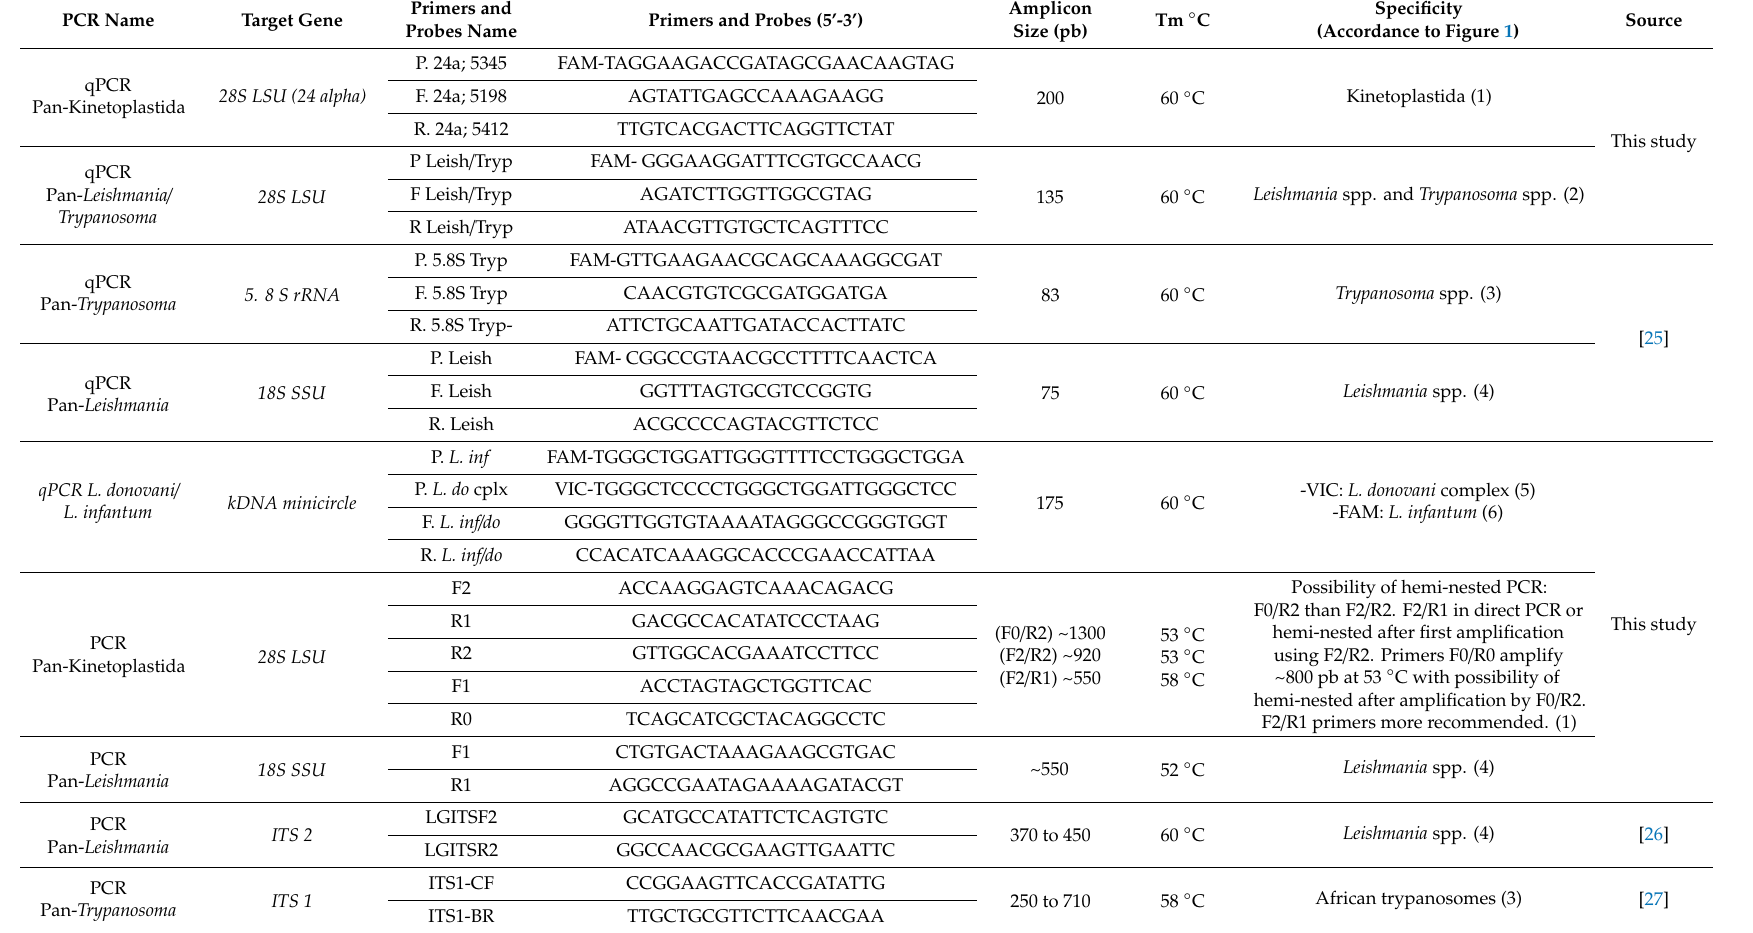
Table 1. Primers and Probes, their Characteristics and